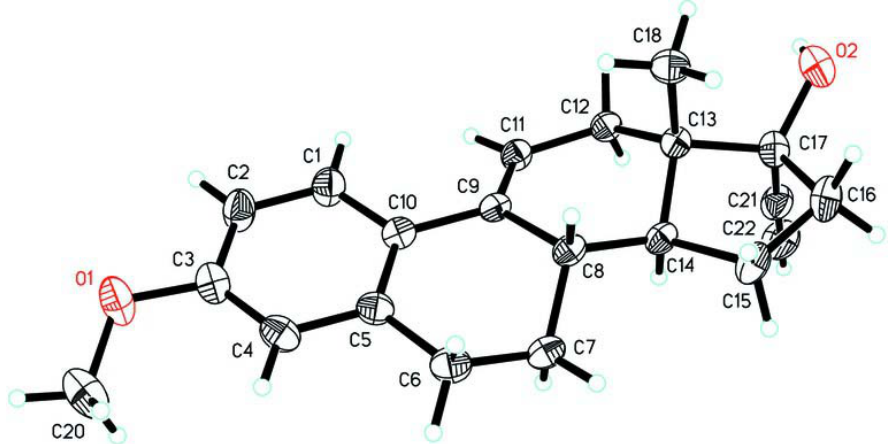
Figure 1 The molecular structure of the title compound. Displacement ellipsoids are drawn at the 30% probability level and H atoms are shown as small spheres of arbitrary